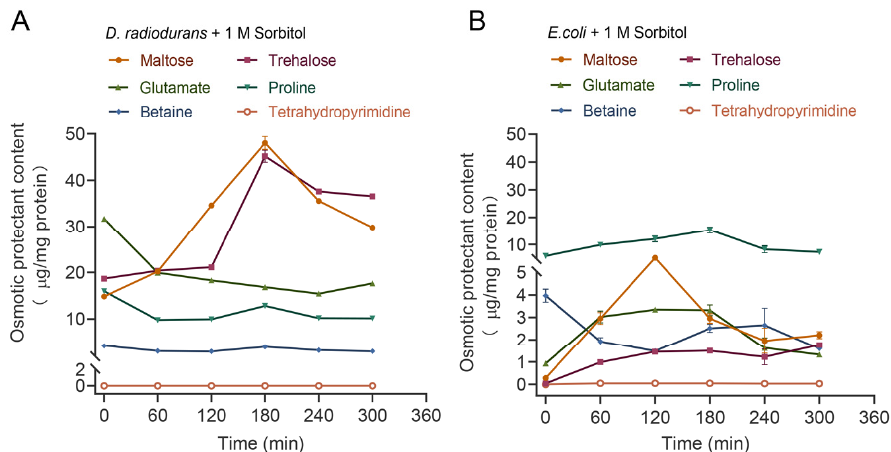
Figure 7. Composition of the compatible solute pool of different strains under 1.0 M sorbitol stress. ( A ) D. radiodurans R1 wild-type. ( B ) E. coli DH5 α . Filled circles, maltose; filled squares, trehalose; filled triangles, glutamate; filled inverted triangles, proline; filled diamonds, betaine; open circles, tetrahydropyrimidine.